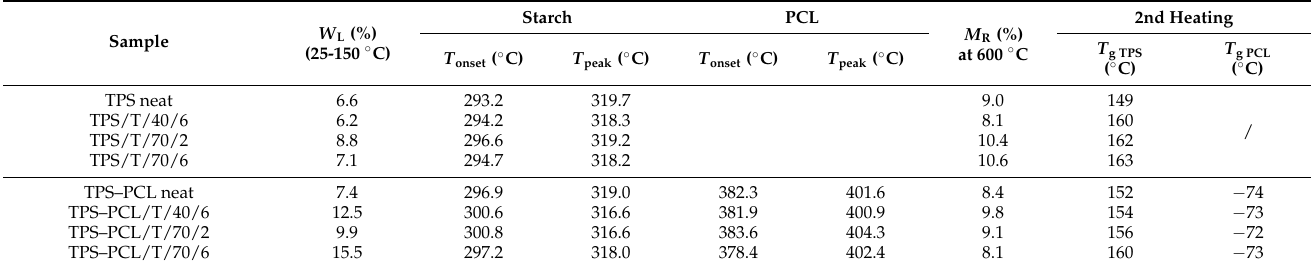
Table 3. Thermal properties of neat and impregnated TPS and TPS–PCL